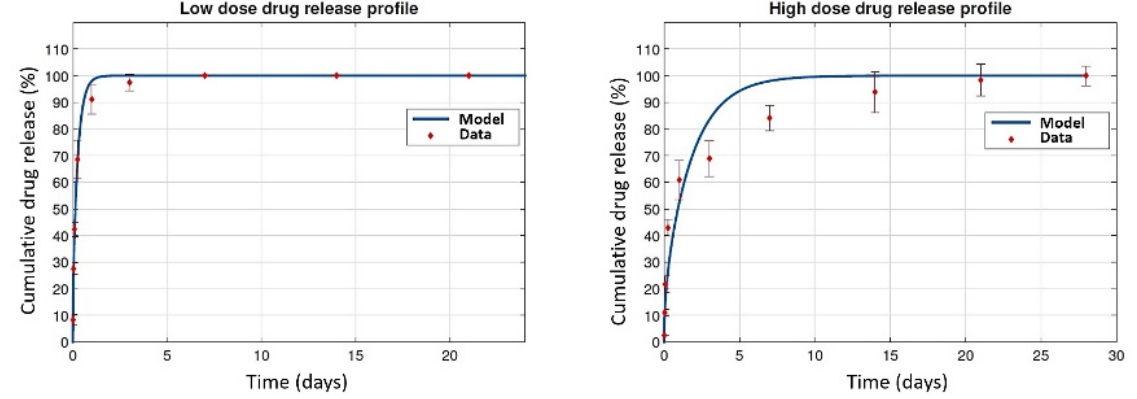
Figure 16. Comparison between experimental in vitro drug release data (normalized by the cumu- lative mass eluted by the final measurement time point), and model simulations. LEFT: The low dose stent was well-fitted by a diffusion coefficient of the order of 10 − 16 m 2 s − 1 . RIGHT: The fit between the diffusion model and the data from the high dose stent was not so good. Furthermore, the best-fitting diffusion coefficient was of the order 10 − 17 m 2 s − 1 , reprinted from [108]. Reproduced with permission from Craig M. McKittrick, Sean McKee, Simon Kennedy, Keith Oldroyd, Marcus Wheel, Giuseppe Pontrelli, Simon Dixon, Sean McGinty, Christopher McCormick, An Overview of